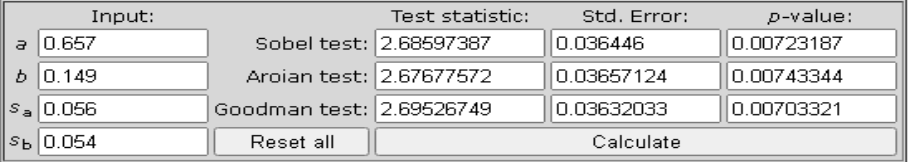
Table 5: Online Sobel Test The Role of Job Satisfaction Mediation